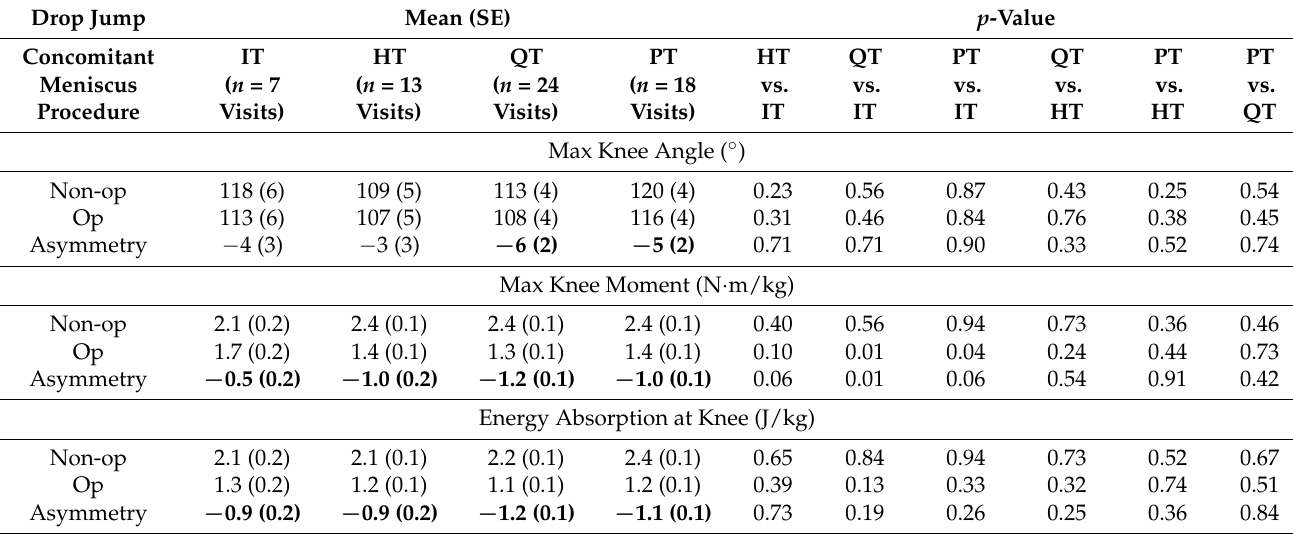
Table A3. Comparison of sagittal knee kinematics/kinetics for operative and non-operative limbs during vertical drop jump for patients with concomitant meniscus repair, debridement, or